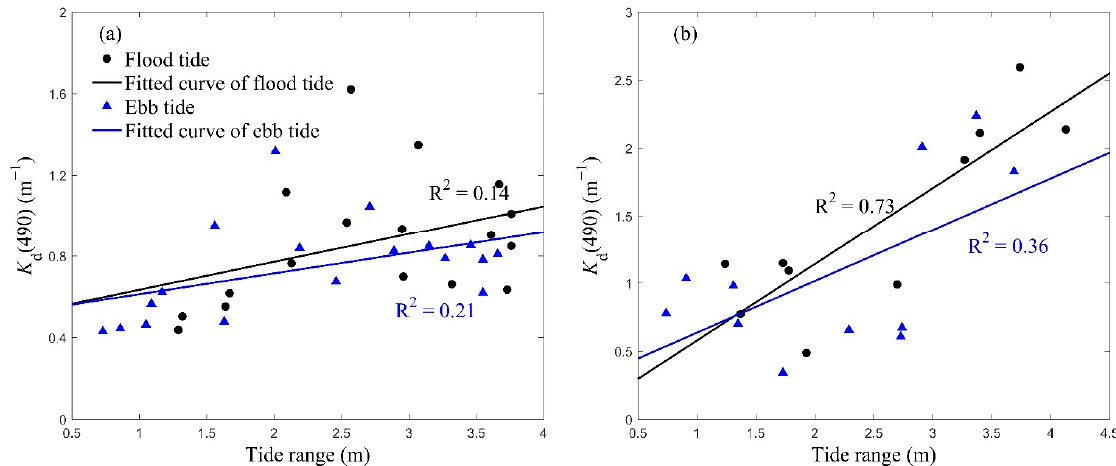
Remote Sens. 2021 , 13 , x FOR PEER REVIEW Figure 14. Relations between the mean value of K d ( 490 ) and tide range of a flood or an ebb tide in different seasons. ( a ) Data for autumn (from 20 September to 5 October) and ( b ) data for winter (from 8 November to 11 January).